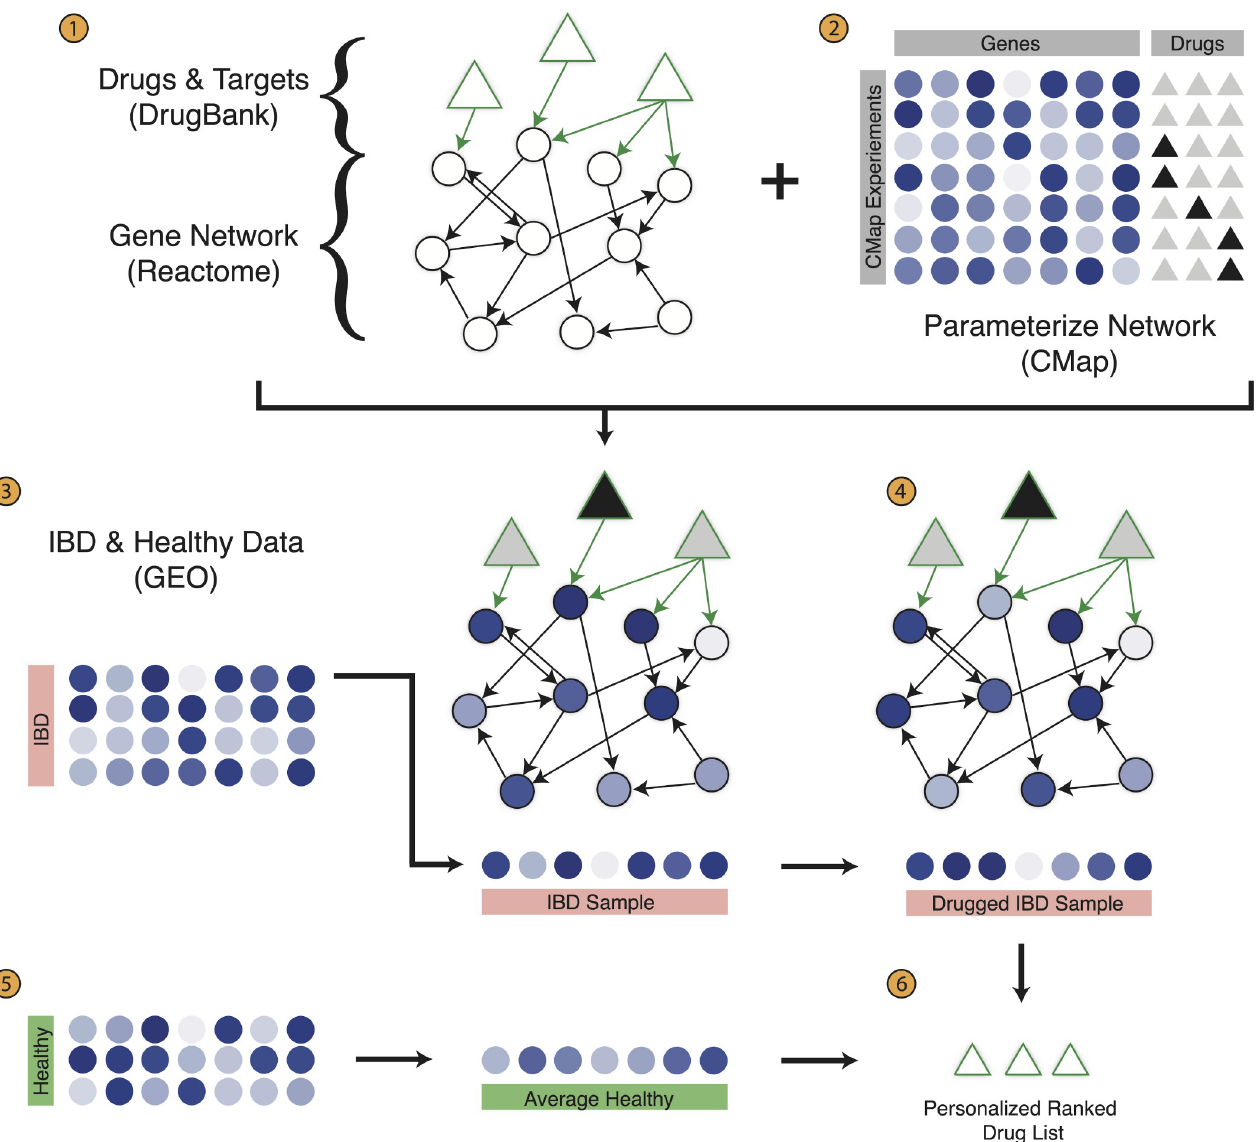
Fig 1. Overview of drug effect modeling. (1) Drugs, drug targets, genes, and gene interactions are curated from DrugBank and Reactome to form a gene-drug network. (2) The expression of each gene is modeled as a linear regression of incoming nodes, where the coefficient parameters are learned from the Connectivity Map. (3) IBD data is curated from the Gene Expression Omnibus (GEO), and for each sample (4) a drugged IBD sample is created using the network. (5) The healthy samples are averaged to create a healthy patient representation, and (6) each drugged IBD sample is compared to the healthy sample using Euclidean distance to create a personalized ranked drug